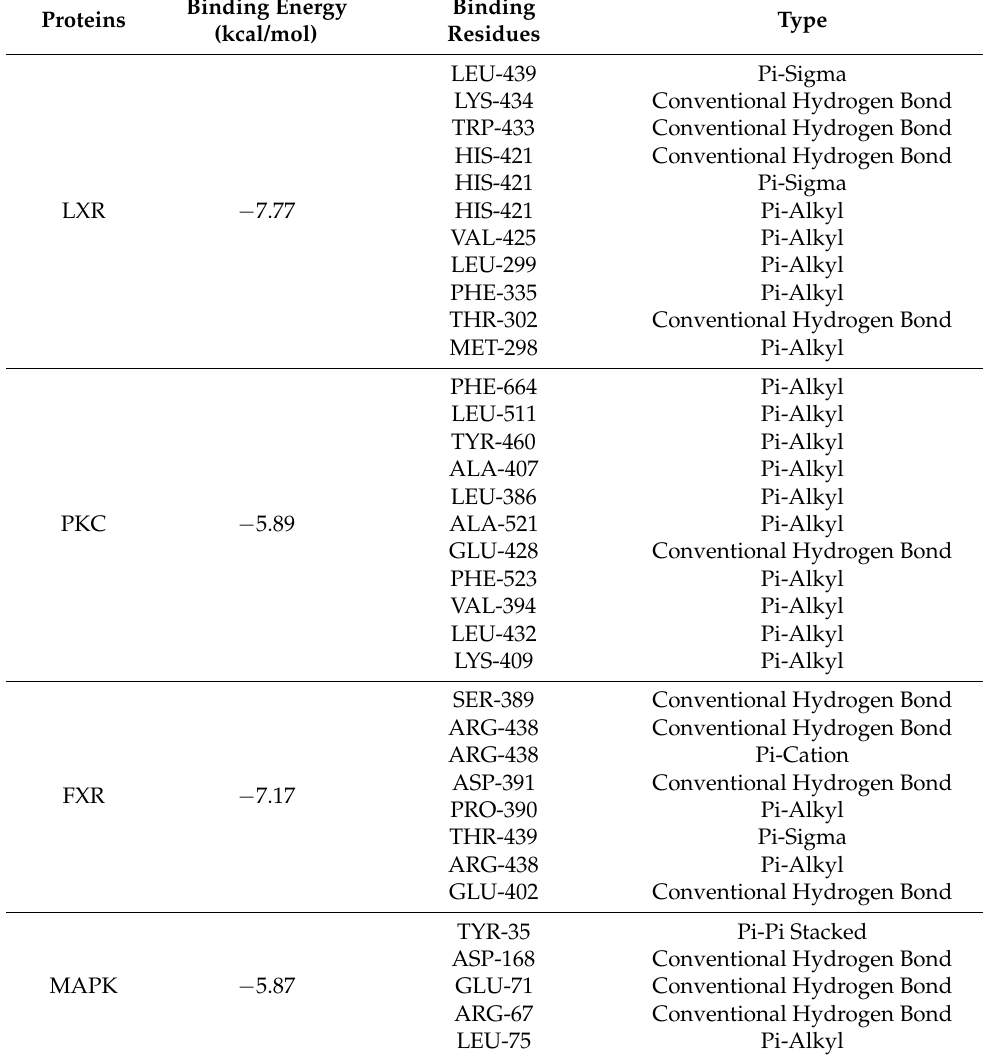
Table 2. Intermolecular interactions between rosmarinic acid and LXR, PKC, FXR, and MAPK.